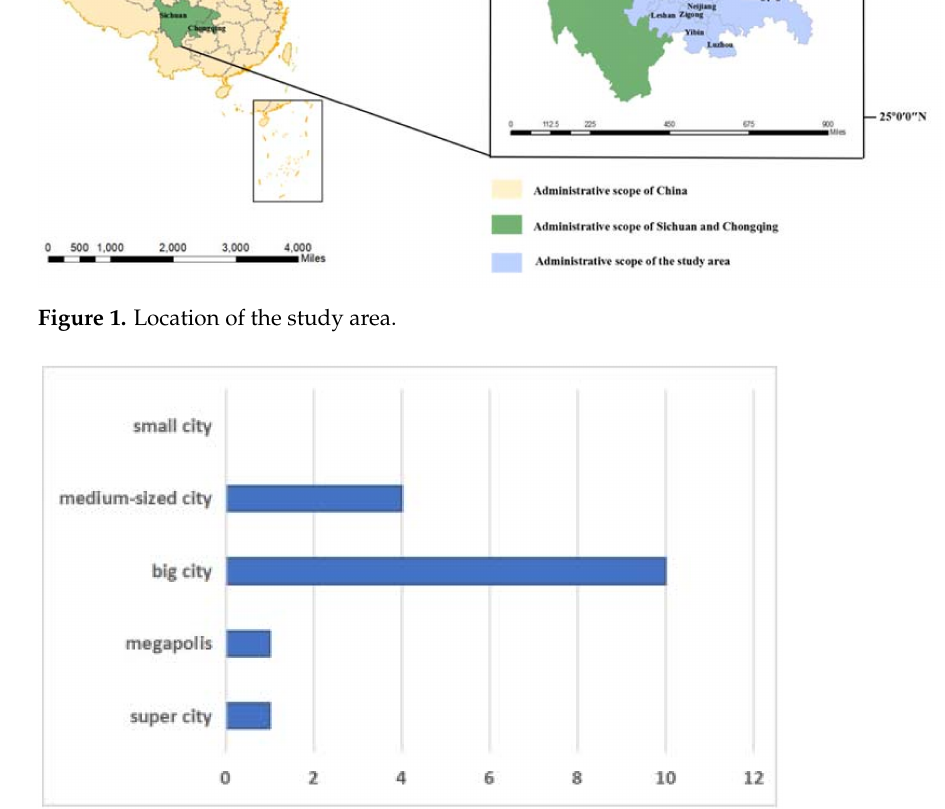
Figure 2. City scale distribution map of the Chengdu–Chongqing urban